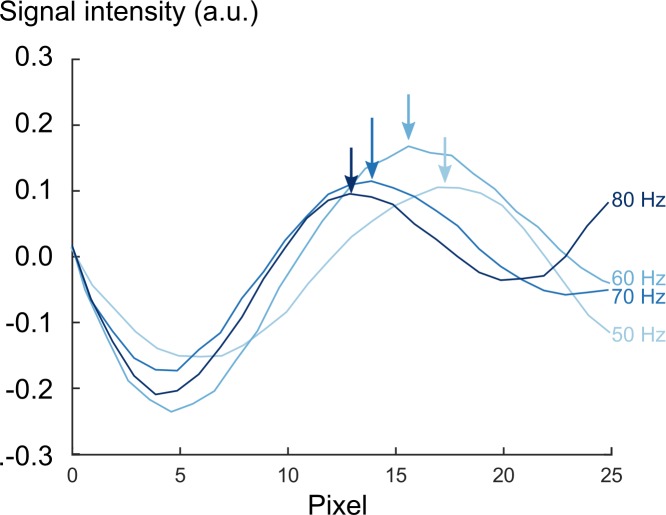
Line profiles of phase signal at 50 Hz, 60 Hz, 70 Hz, and 80 Hz in Inclusion A.A 25-pixel-line was placed in inclusion A and compared at four actuation frequencies. The wave length shortened with increasing frequencies as indicated by arrows at the first maximum of each line profile.